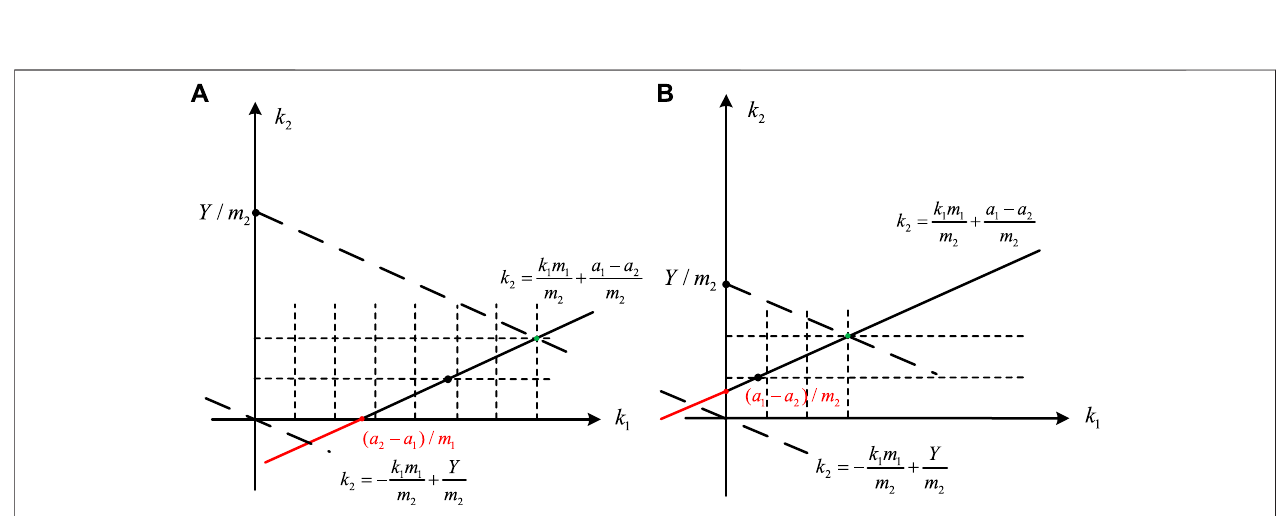
FIGURE5|(A) Schematicdiagramof k 1 increasingsequentiallywhena 2 > a 1 and m 1 / m 2 > 1. (B) Schematicdiagramof k 1 increasingsequentiallywhena 2 < a 1 and m 1 / m 2 > 1.